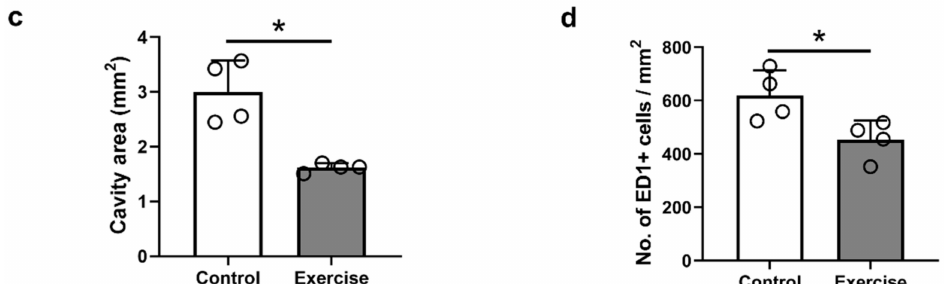
Figure 2. Histological analysis of the injured spinal cords at 12 weeks after injury. Representative images of ( a ) H&E staining and ( b ) immunofluorescent staining for ED1 (green) and GFAP (red) in the control and exercise groups. ( c ) The cavity area measured from the sagittal images of H&E staining ( n = 4 per group). ( d ) Number of ED1-positive macrophages counted in the lesion area from immunohistochemical staining ( n = 4 per group). * p < 0.05 between the control and exercise groups by the Mann–Whitney U test. Black and yellow scale bars = 500 µ m, white scale bar = 100 µ m.